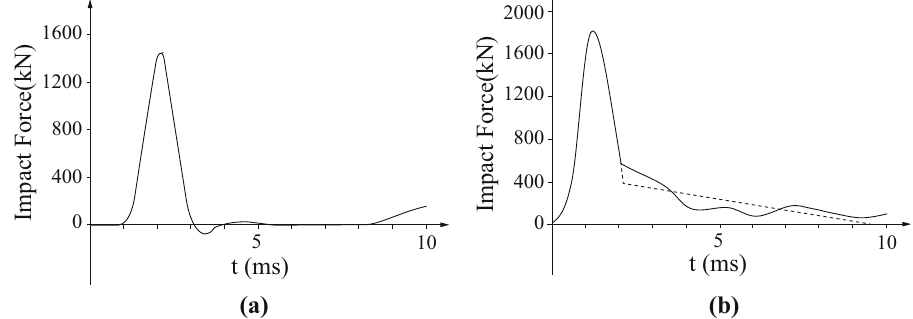
Fig. 12 Impact force–time history for beams a SS3a and b SS3b.